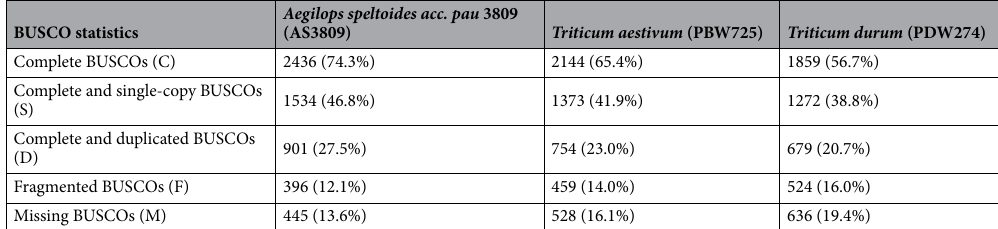
Table 2. Summary of the complete, duplicated, fragmented and missing orthologs inferred from BUSCO searched against the 3278 single-copy orthologs for Liliopsida.